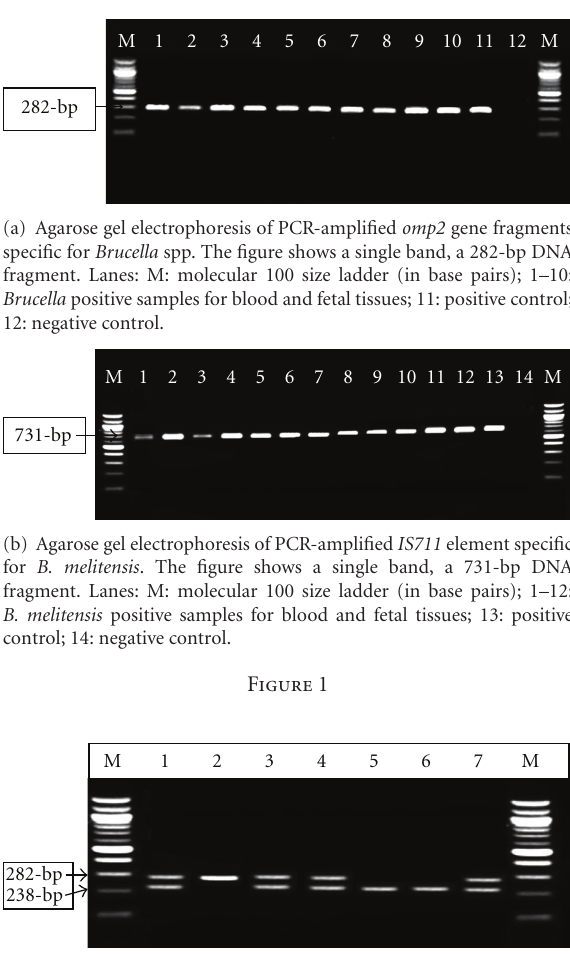
Figure 2: Agarose gel electrophoresis of Pst I digests of amplified omp2 gene fragments from Brucella spp. The figure shows the uncut 282-bp DNA and the larger, Pst I-digested (238-bp) DNA fragments. The smaller 44-bp DNA fragment is not shown. Lanes: M: molecular 100 size ladder (in base pairs); 1, 3, and 4: B. melitensis Rev-1 like isolates (282 and 238-bp); 2: uncut B. melitensis isolates (282-bp); 5 and 6: B. melitensis field strain isolates (238-bp); 7: B. melitensis Rev-1 vaccine as a positive